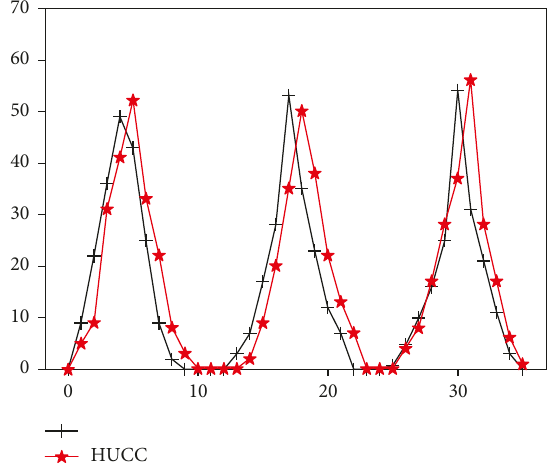
Figure 4: Comparison of request distribution between HUCC and ordinary traffic.